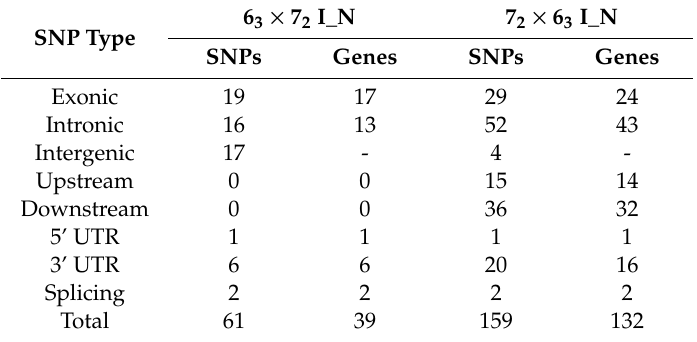
Table 4. Classification of ASE SNPs responding to Marek’s disease virus (MDV)